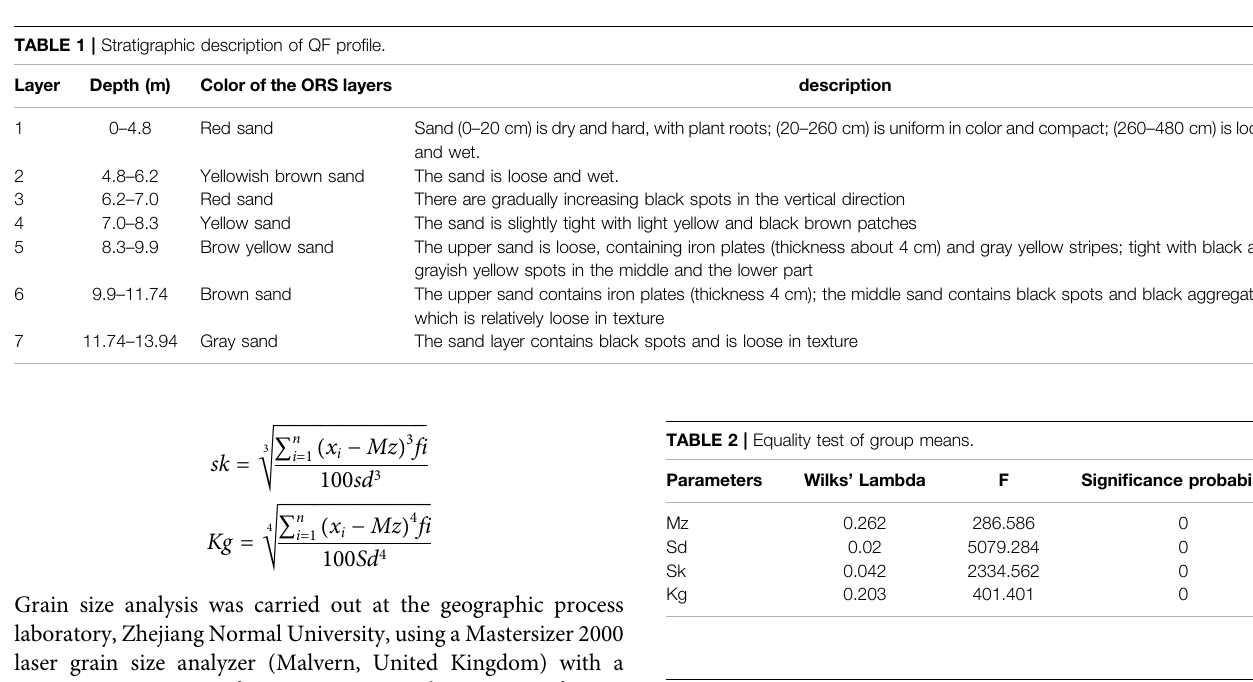
TABLE 3 | Box ’ s M test results of equality covariance